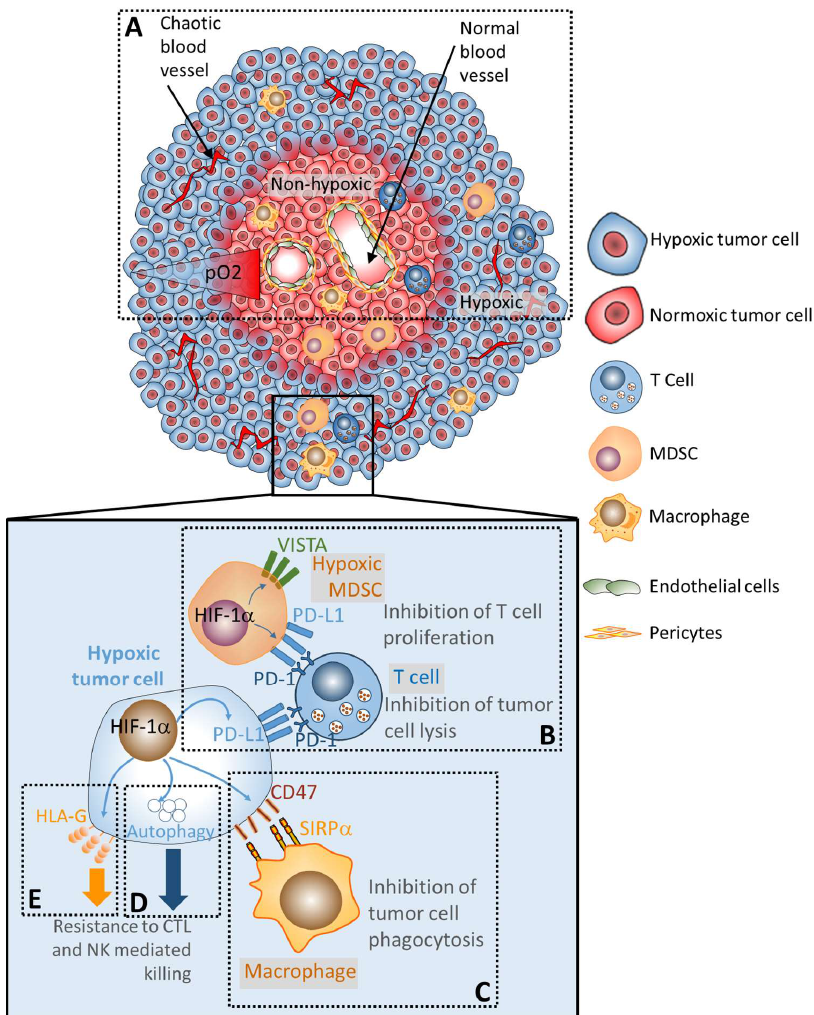
Figure 1. The hypoxic tumor microenvironment and its impact on anti-tumor immunity. ( A ) Hypoxia is established in the tumor microenvironment due to an increase in tumor cell proliferation, and a decrease in oxygen supply. Non-hypoxic tumor regions displayed normal blood vessels covered by well-organized endothelial cells and pericytes. In hypoxic tumor regions, the pressure of oxygen is low which arises from oxygen di ff usion limitations due to disorganized, chaotic tumor microvasculature network with leaky vessels. ( B ) Under hypoxia, the stabilization of hypoxia-inducible factor (HIF)-1 α in cells upregulates the expression of PD-L1 in hypoxic tumor cells and PD-L1 and VISTA in hypoxic MDSCs. The increased expression of PD-L1 and VISTA results in an inhibition of T cell proliferation and T cell mediated lysis. ( C ) HIF-1 α is also involved in the upregulation of cluster of di ff erentiation 47 (CD47) on the surface of tumor cells. Following the binding of CD47 to signal regulatory protein α (SIRP α ), expressed on the surface of macrophages, tumor cells provide a strong “don’t eat me signal” to block phagocytosis property of macrophages. ( D ) The activation of autophagy in hypoxic tumor cells impairs tumor cell susceptibility to CTL and NK-mediated lysis by at least two distinct mechanisms involving the degradation of NK-derived Granzyme B and the stabilization of pSTAT3. Other hypoxia-dependent, but autophagy-independent, mechanisms are described in this review including the overexpression of NANOG and miR-210 targeting PTPN1, HOXA1, and TP53I11. ( E ) Hypoxia upregulates the expression of HLA-G on the surface of tumor cells. The upregulated HLA-G binds to ILT2, ILT4 and KIR2DL4 expressed by several immune cells (B and T cells, NK cells, myelomonocytic cells, dendritic cells, monocytes and macrophages) leading to tumor escape from immune